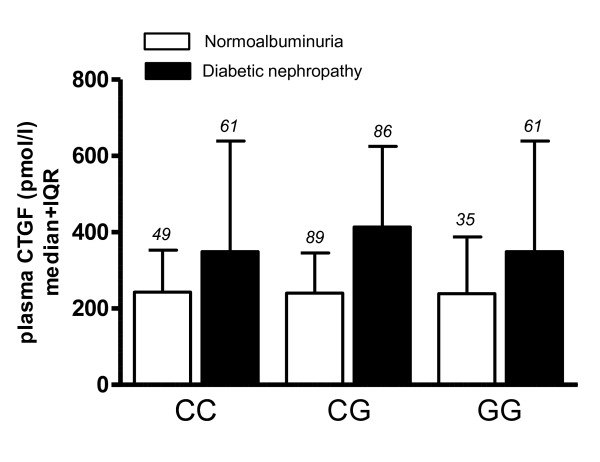
Relation of plasma CTGF levels (pmol/l) with genotype. Bars are median+interquartile range. White bars: normoalbuminuric diabetic patients (N = 173); black bars: diabetic patients with nephropathy (N = 198). Plasma CTGF levels are higher in DN (p < 0.0001, ANOVA on log transformed values for conversion to a normal distribution of positively skewed data). There is no significant difference in plasma levels according to genotype. Number of patients in each group is indicated in italics above the error bars.